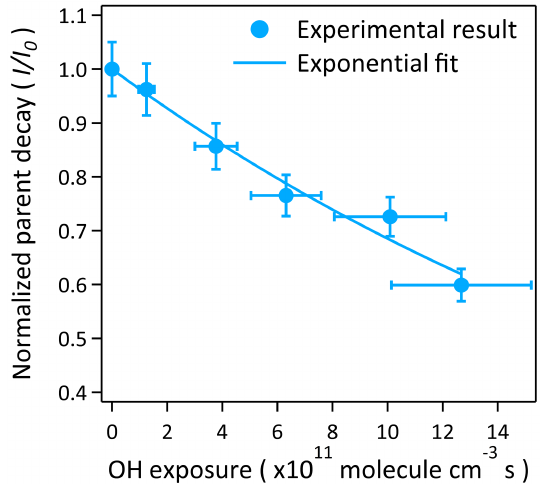
Figure 3. The normalized decay of sodium methyl sulfate as a func- tion of OH exposure during the heterogeneous OH